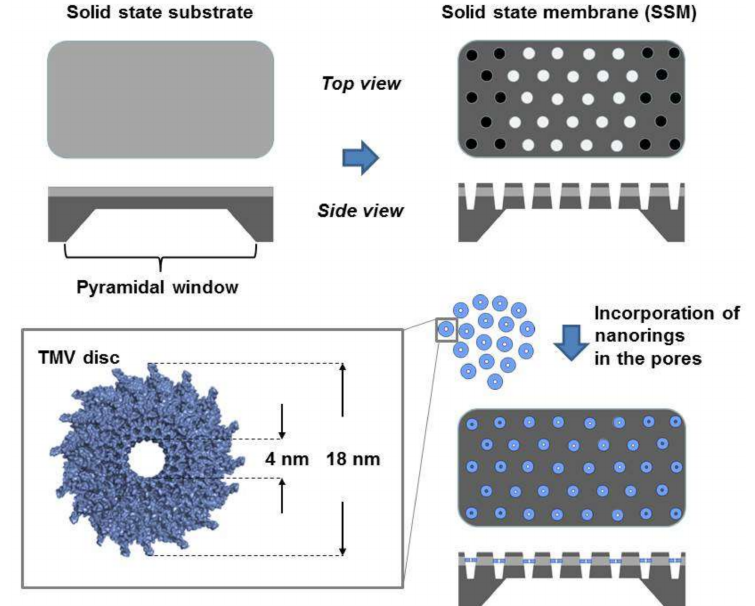
Figure 1. Scheme of the membrane based on the “pore-in-pore” structure. The virus-based nanorings are incorporated in the conical pores of the solid state membrane (SSM). The 4-nm pin holes of the nanodiscs may act as a molecular filter with exactly defined protein pore diameters. For the tobacco mosaic virus (TMV) disc structure, see